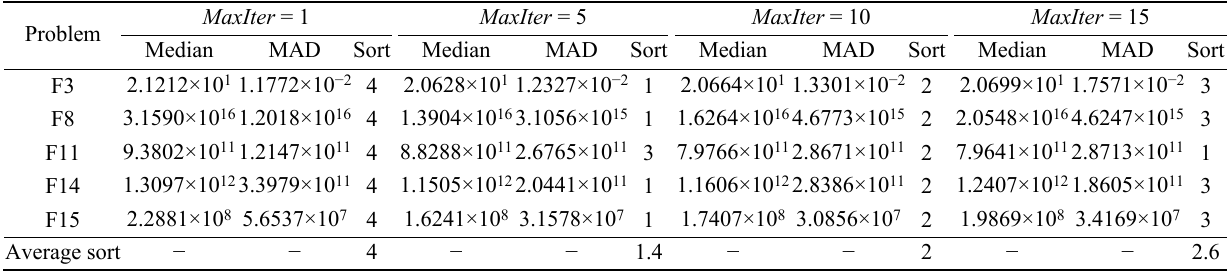
Table 1 Statistical results of the optimal objective values, given in median and median absolute deviation (MAD), on F3, F8, F11, F14, and F15 problems obtained by different maximum optimal iteration numbers. MaxIter = 1 MaxIter = 5 MaxIter = Problem